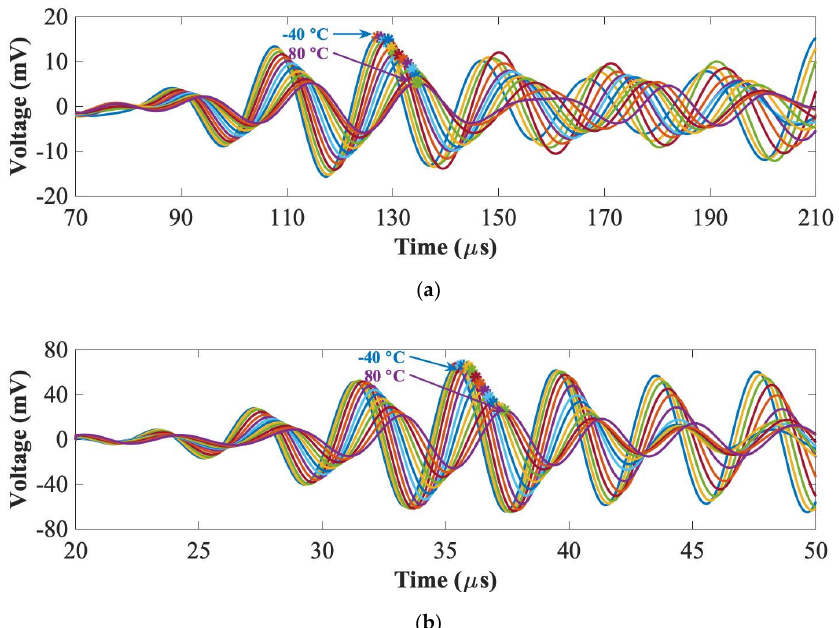
Figure 7. UGWs with peak amplitudes under varying temperatures at 50 kHz ( a ) and 250 kHz ( b) for the 2 mm thick panel.